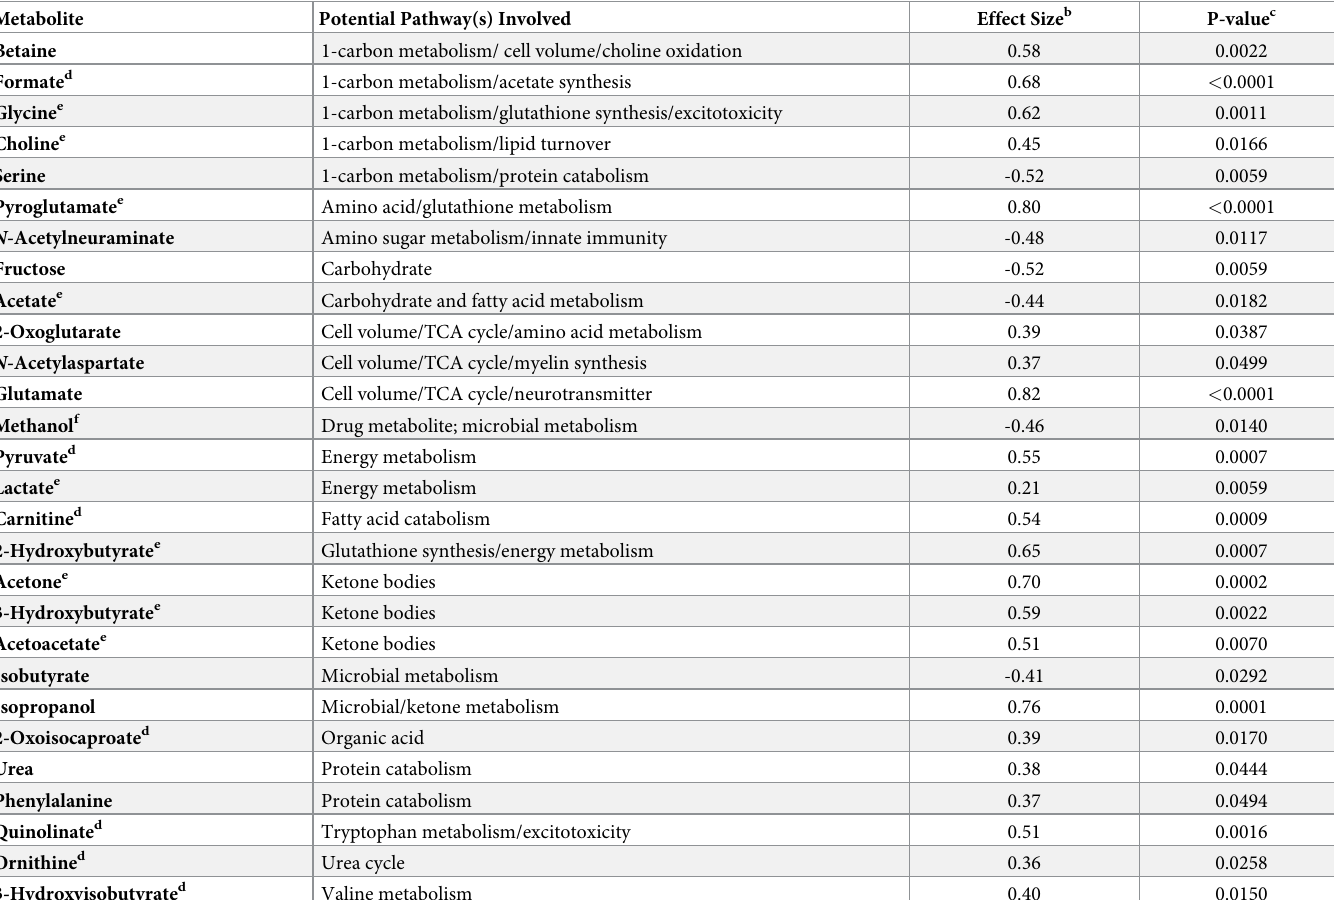
Table 2. Differences in cerebrospinal fluid metabolite concentrations between patients with an infectious disease ( Hisotoplasma , Lyme, rabies, West Nile virus) and non-infectious conditions (multiple sclerosis, controls) a . Metabolite Potential Pathway(s)